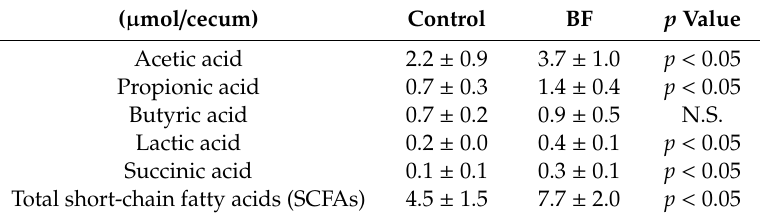
Total short-chain fatty acids (SCFAs) Values are mean ± SD, N.S.: not significant di ff